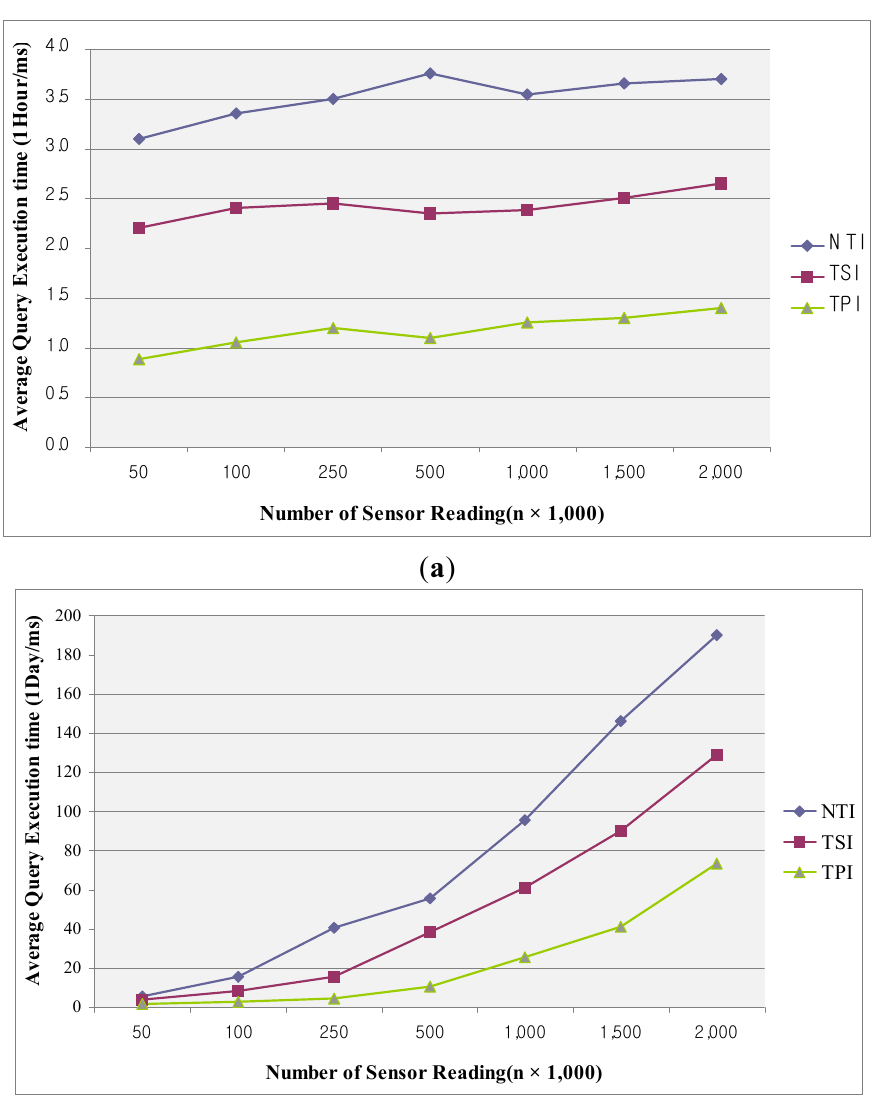
Figure 13. Average query execution time as a function of the number of sensor readings (1 h) ( a ); and (1 day) ( b